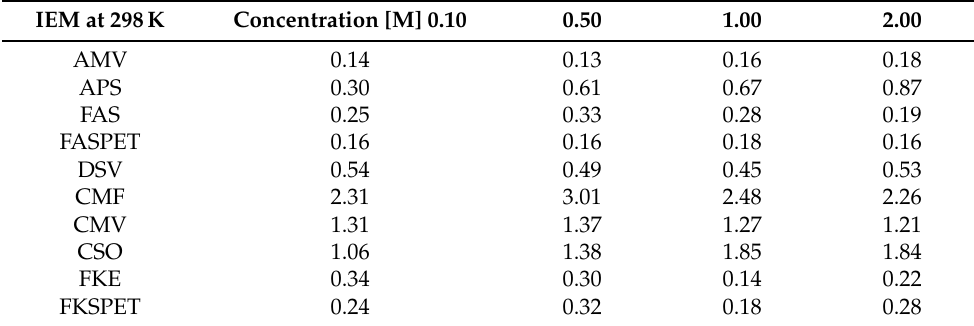
Table A5. Mean IEM conductivities [Sm − 1 ] at 298 K.